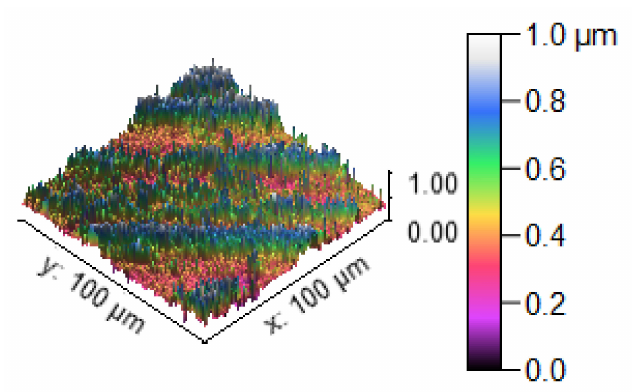
Figure 14. Three dimensional (3D) profilometric image (S-2).